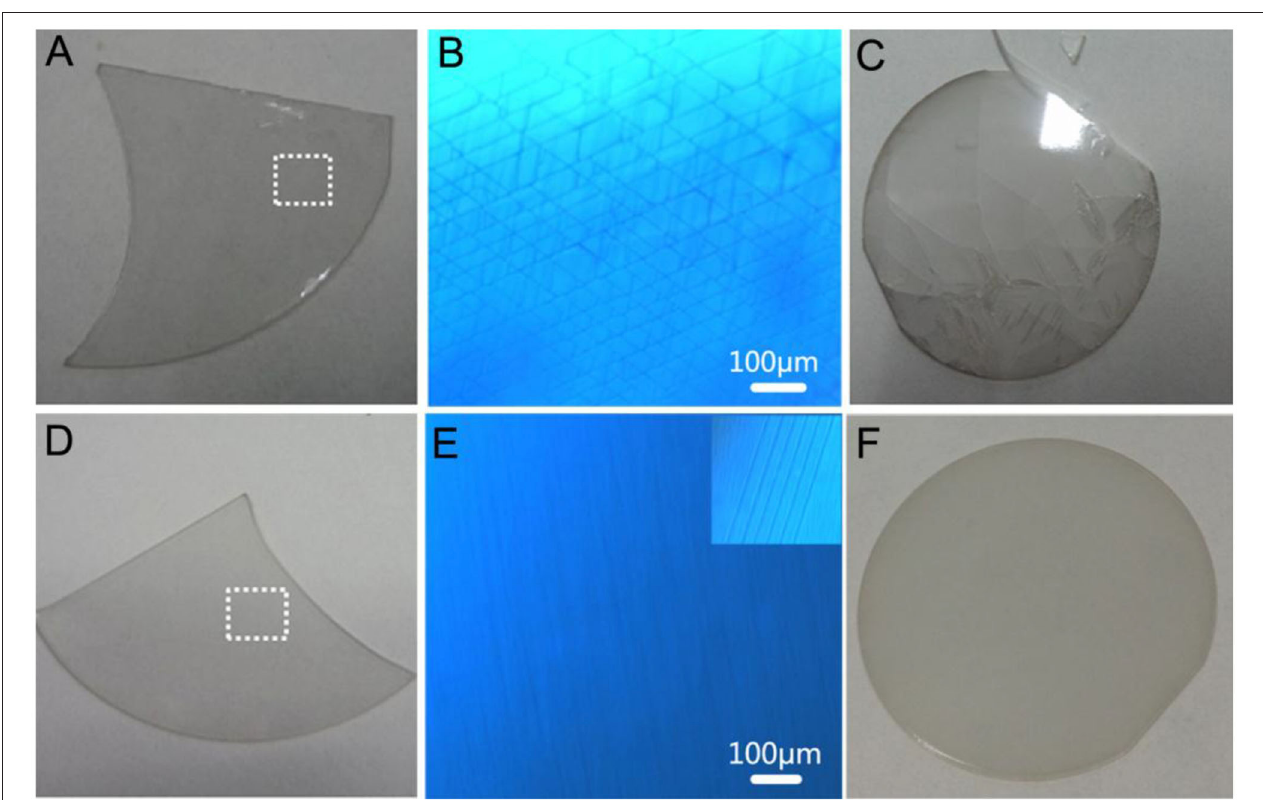
FIGURE 3 | Photographic and optical microscopic images of GaN films grown above LT-AlN with no annealing treatment (A–C) (sample A) and with annealing pre-treatment (D–F) (sample B) [the thicknesses of GaN for (A,D,C,F) are 20 and 100 µ m, respectively]. (B,E) Microscopic images of the dot white rectangle of (A,D) , respectively, where the insert of (E) shows the local micro-crack in (D)